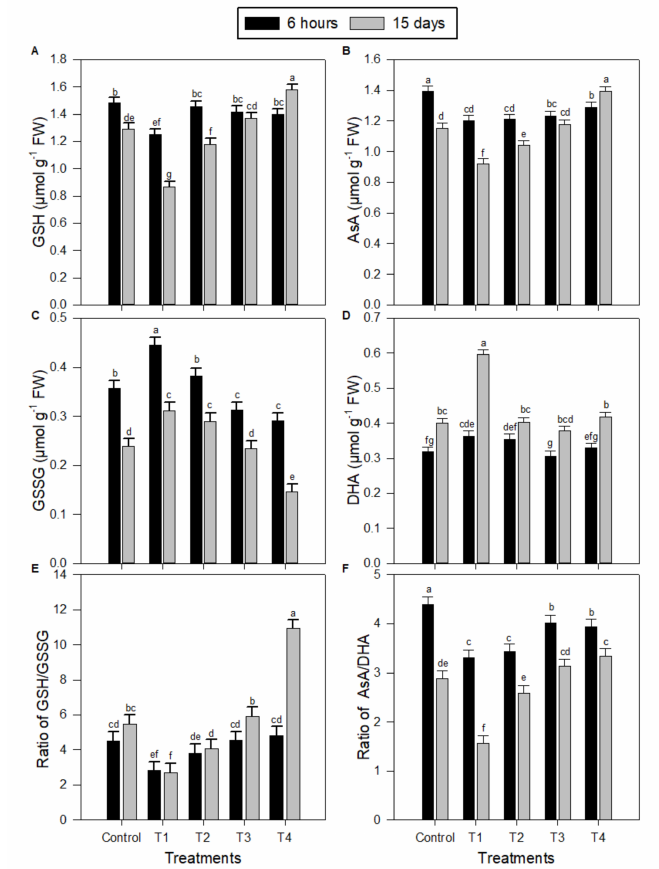
Figure 2. E ff ect of salinity stress alone or combined with exogenous melatonin on antioxidant system components in peanut seedlings after 6 h and 15 days. ( A ) Reduced glutathione (GSH), ( B ) ascorbate (AsA), ( C ) oxidized glutathione (GSSG), ( D ) dehydroascorbate (DHA), ( E ) the ration of GSh / GSSH, and ( F ) the ratio of AsA / DHA. Data are means ± SD ( n = 3) from three independent experiments. The bars labelled with di ff erent letters are significantly di ff erent. The significant di ff erence marked by di ff erent letters was calculated using the Student’s t -test and further analyzed with the Fisher LSD test, at p ≤ 0.05. The legends are as follows: Control: 0 NaCl + 0 MT, T1: 150 mM NaCl + 0